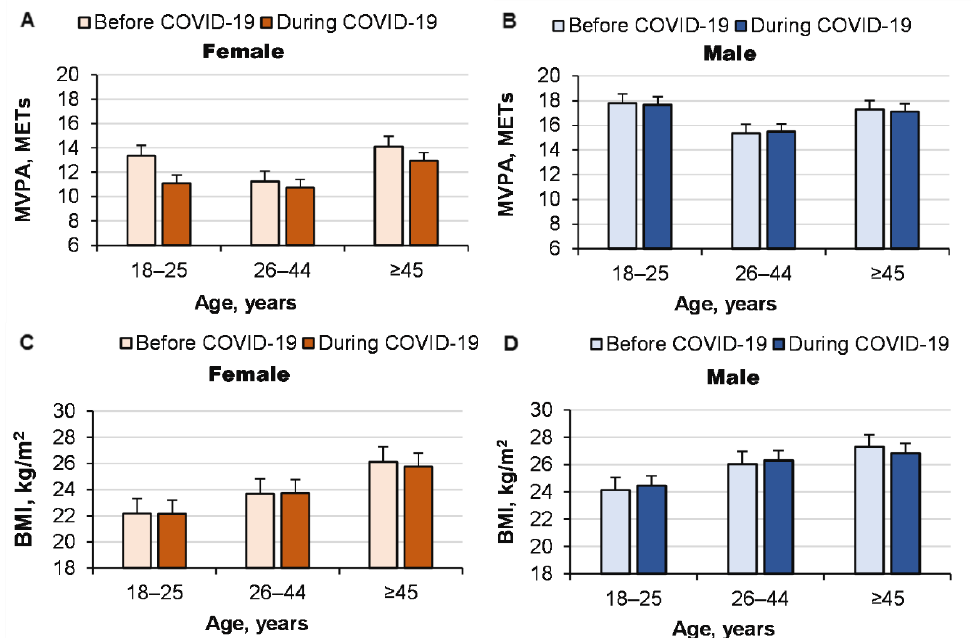
Figure 5. MVPA (A,B) and BMI (C,D) before and during the COVID-19 pandemic. Figure 5. MVPA ( A , B ) and BMI ( C , D ) before and during the COVID-19